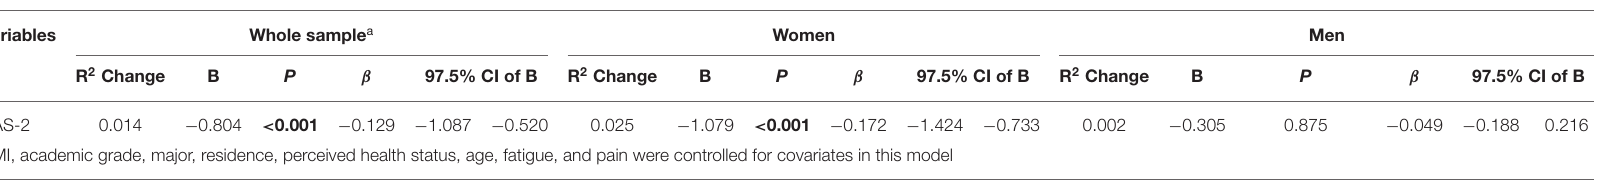
TABLE 2 | d Unique associations of BAS-2 scores with depression, anxiety, and suicidality in the total sample and by gender after controlling for demographics and background measures (see the complete hierarchical regression results in Supplementary Table 1 ). 1. Hierarchical multiple linear regression with depressive symptoms as the dependent variable